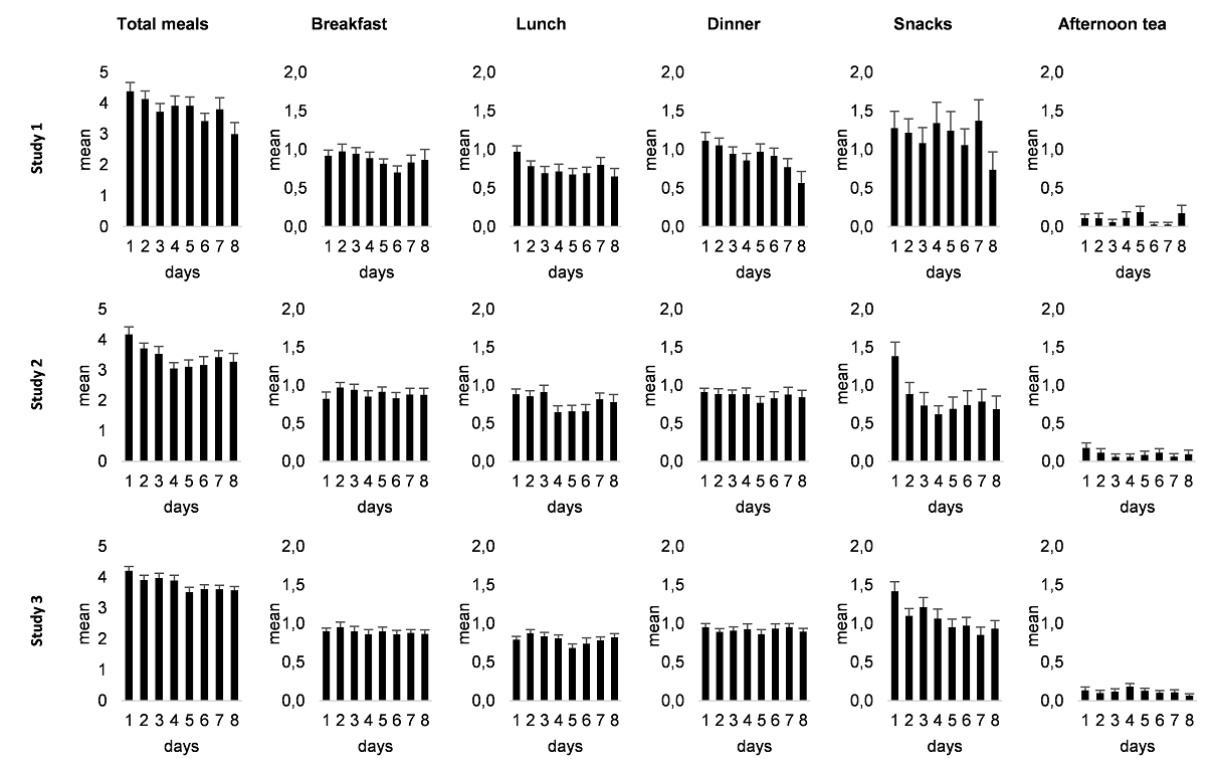
Figure 1. Average logging trajectories across the 8-day study period for studies 1, 2 and 3 across all meals and by meal types. Bars represent mean logged meals; error bars represent the standard error of the